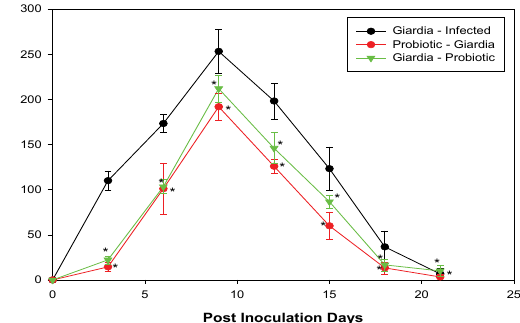
Figure 1. Giardia cysts in faeces of mice belonging to different groups employing L. acidophilus as the probiotic. Values are mean ± standard error (SE), * p < 0.05 v/s Giardia- Infected (days 3, 5, 7, 9, 11, 13, 15, 18, 21).